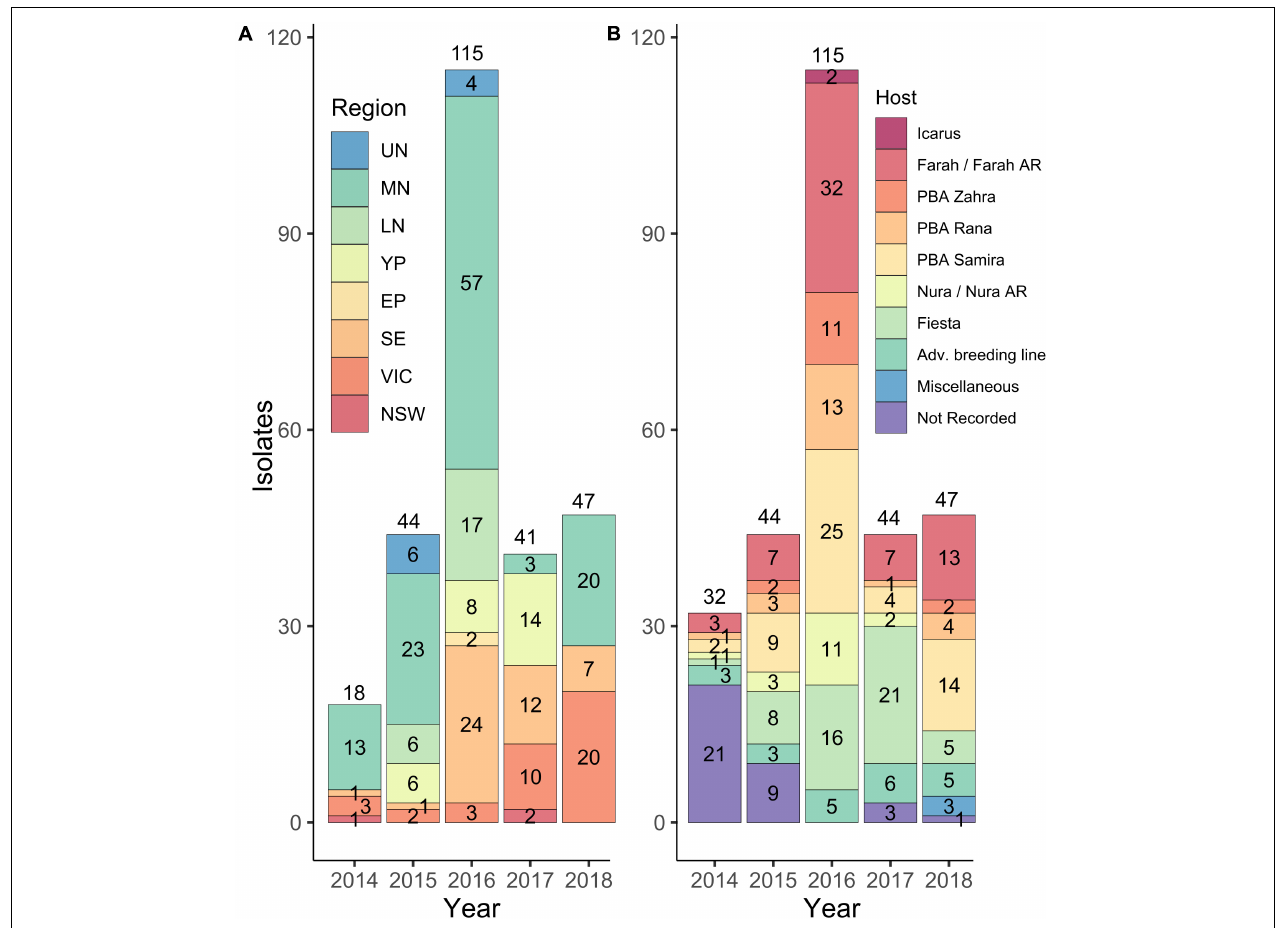
FIGURE 1 | Numbers of A. fabae isolates were collected from 2014 to 2018 from South Australia (SA), Victoria (VIC), and New South Wales (NSW) and held in the South Australian Research and Development Institute (SARDI) isolate collection. Isolates are grouped by region (A) and by host cultivar from which they were collected (B) . Regions are abbreviated as follows: Upper North SA, UN; Mid North SA, MN; Lower North SA, LN; Yorke Peninsula SA, YP; Eyre Peninsula SA, EP; South East SA, SE; Victoria, VIC, and New South Wales, NSW. Region classifications in (A) do not include isolates collected in 2014 with no region recorded (14) and do not include those collected in 2017 from Adelaide City (2) and Fleurieu (1). Host cultivar classifications in (B) included some advanced breeding lines (Adv. breeding line). In 2018 three isolates classified as Miscellaneous, were collected from cultivars Aquadulce, Doza, and Fiord, respectively.